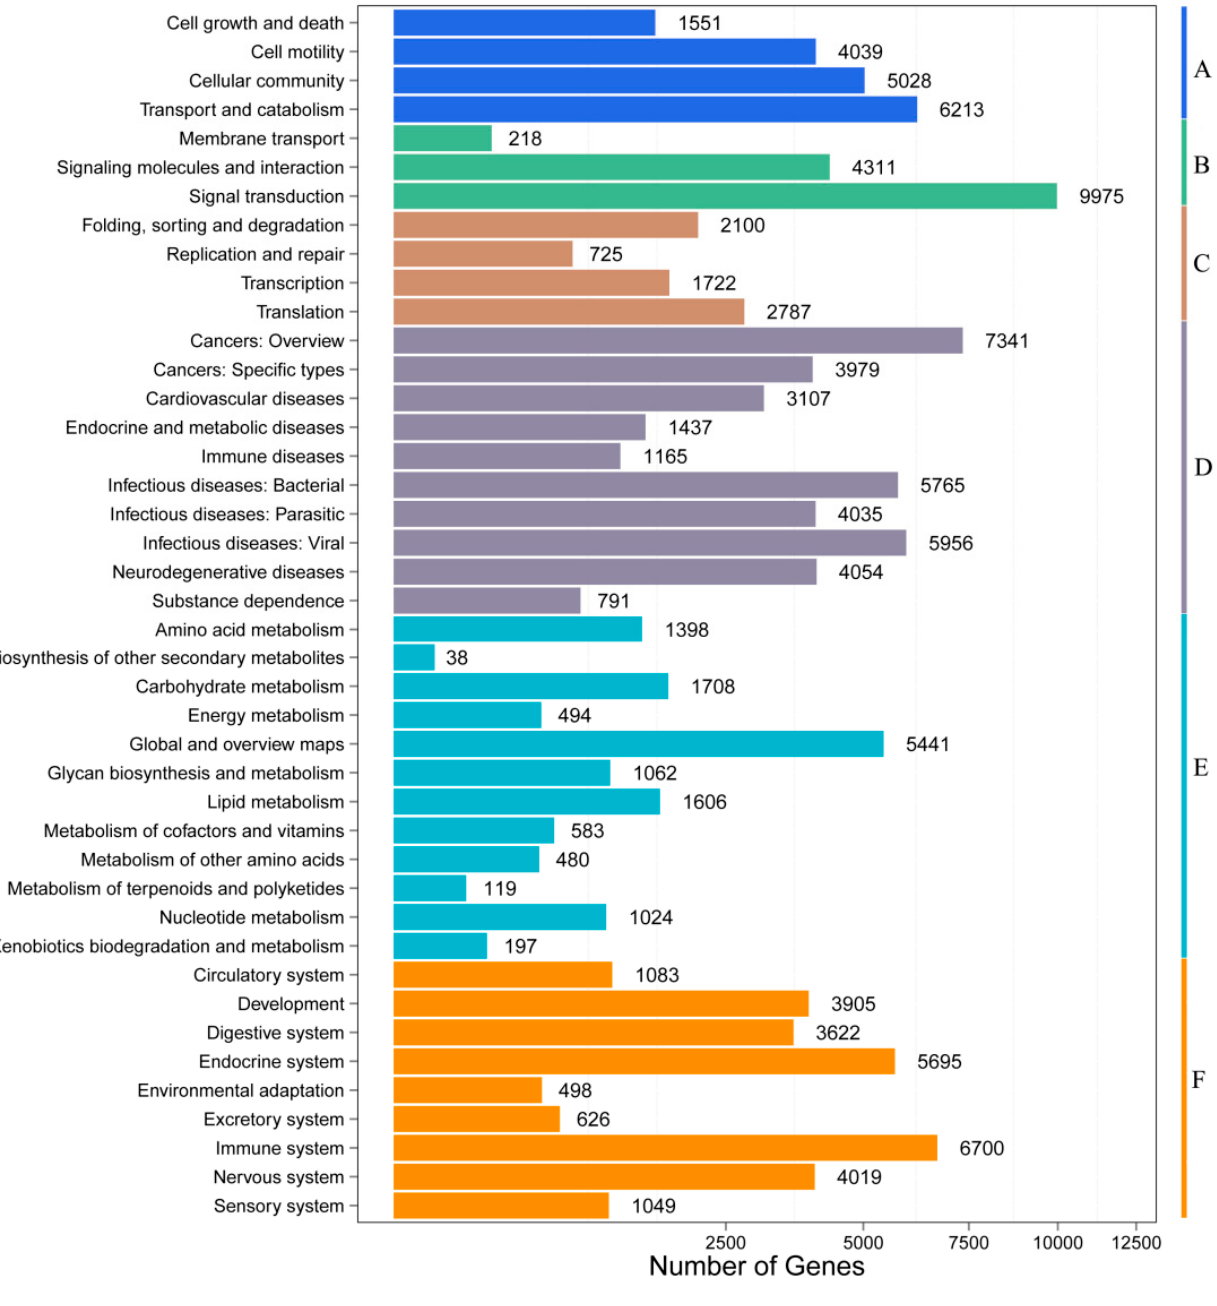
Figure 3. KEGG pathway analyses for all annotated unigenes. The horizontal indicates the number of genes in a category. The left y-axis indicates the identified KEGG pathways. The right y-axis indicates the six groups of KEGG enrichment which are: (A) cellular processes; (B) environmental information processing; (C) genetic information processing; (D) human diseases; (E) metabolism; (F) organismal systems.